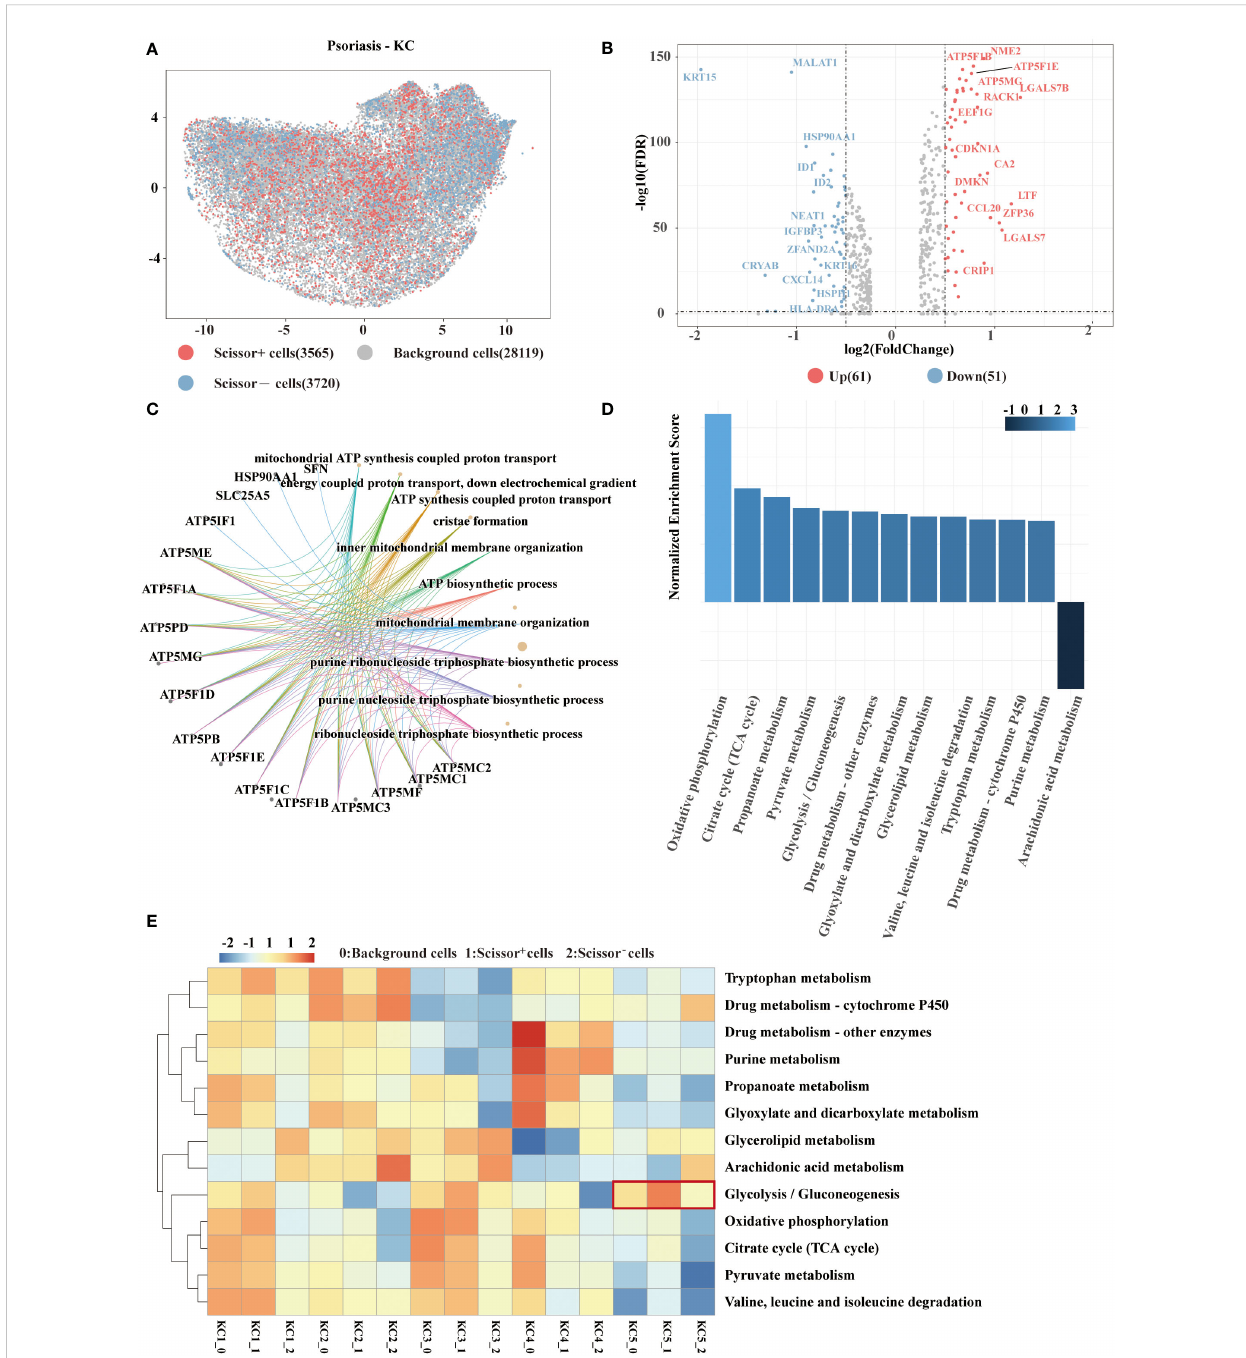
FIGURE 3 Scissor identi fi cation results on psoriasis keratinocytes. (A) UMAP visualization of the Scissor-selected cells. The red and blue dots show Scissor + and Scissor − cells, representing responder and non-responder phenotypes, respectively. (B) Volcano plot of differential gene expressions in Scissor + cells versus Scissor − cells. (C) GO enrichment analysis of differential gene expressions between Scissor + cells and Scissor − cells. (D) GSEA plot of the up and down metabolic pathways. The adjusted P value <0.05. (E) Heat map of enriched metabolic pathways. The red and blue elements suggest the activated and repressed pathways in keratinocytes. GO, gene ontology; GSEA, Gene set enrichment